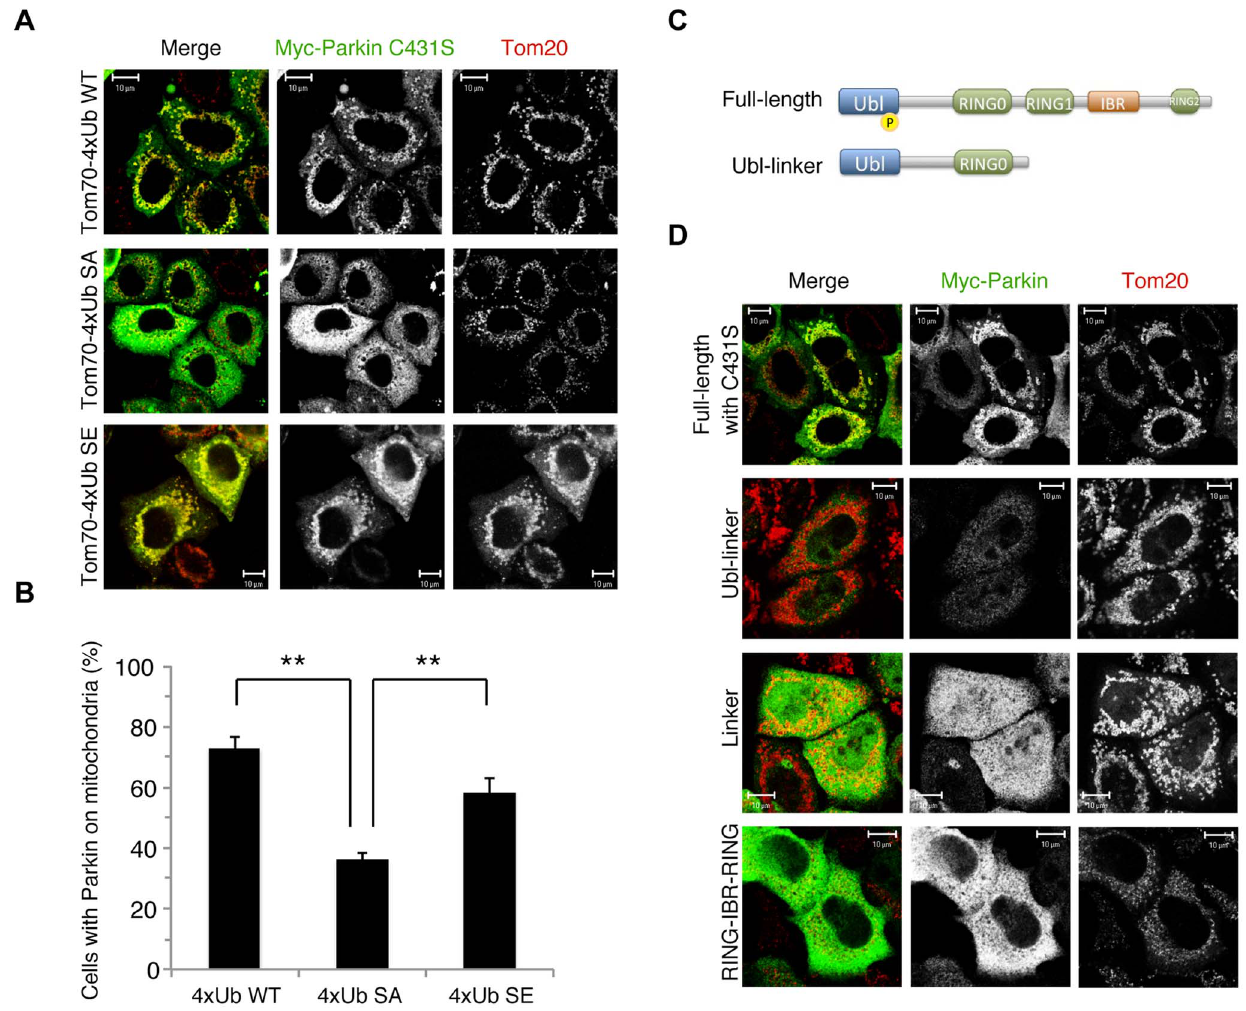
Figure 2. Phospho-polyUb chain mimic stimulates the mitochondrial translocation of Parkin independently of Parkin E3 activity. ( A ) The mitochondrial expression of the non-phosphorylated form of polyUb inhibits Parkin translocation. HeLa cells transfected with Myc-Parkin C431S along with Tom70 MTS -4xUb WT, SA or SE were treated with 10 m M valinomycin for 3 hr. ( B ) Quantification of the mitochondrial translocation efficiency of Parkin C431S. The graph shows the means 6 SEM of the percentages of cells exhibiting mitochondrial recruitment in three independent experiments, with , 100 anti-Myc staining-positive cells counted per sample. ** p , 0.01. ( C ) Diagram of the Parkin protein illustrating the pathogenic mutants used in ( D ). ( D ) Full-length Parkin is required for mitochondrial translocation. HeLa cells transfected with the indicated mutant forms of Parkin along with Tom70 MTS -4xUb WT were treated with 10 m M valinomycin for 3 hr. Scale bars =10 m m in ( A, D ).